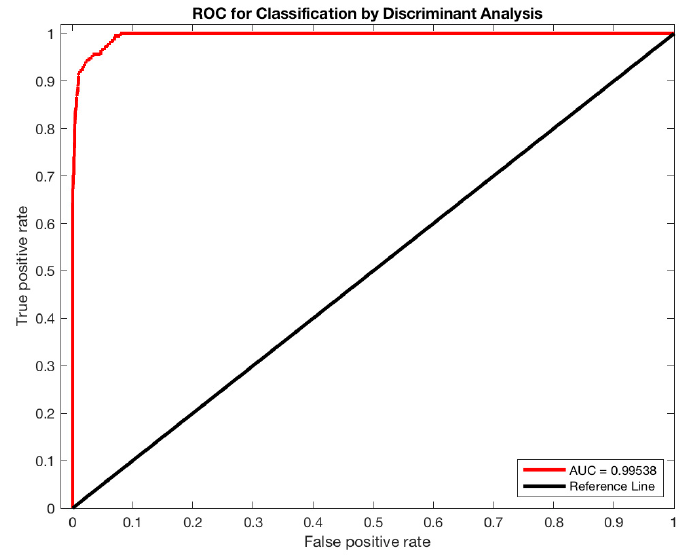
Figure 2. Classification performance of the 3D DA classifier was evaluated by calculating the area under the receiver operating characteristic (ROC) curve (AUC) using the ROC analysis.